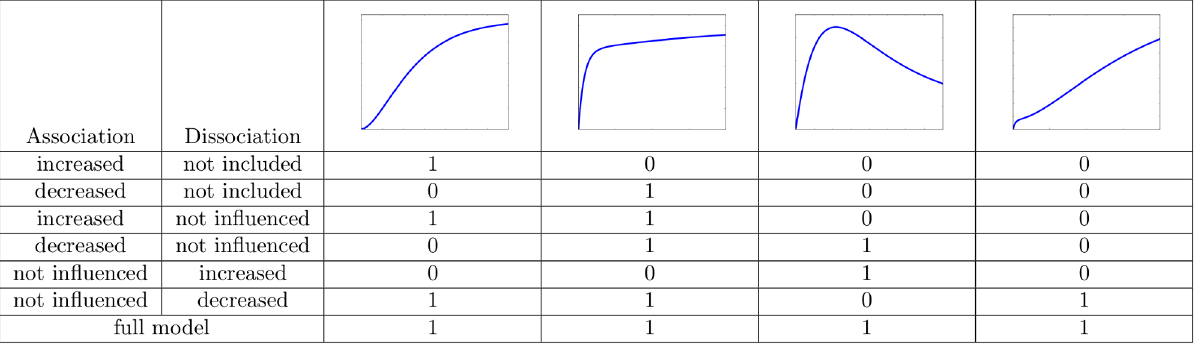
Figure S1 Model in which protein A decreases the ~ 0 . association rate of protein B : Special case k (cid:3) SA z B ~ k (cid:3) ~ 0 : 3 (solid curves), k (cid:3) ~ k (cid:3) ~ 1 : 2 k (cid:3) S z A SB z A S z A SB z A ~ 0 : 5 and k (cid:3) ~ 0 . The recruitment (dashed curves), k (cid:3) S z B SA z B curve of B in the case with low A 0 (solid blue curve) has a higher maximum as the recruitment curve of B in the case with high A 0 (dashed green curve). This feature helps distinguishing the model ~ 0 ) from the model in which there is in which A blocks B ( k (cid:3) SA z B no influence on B . For further explanation see section B1.2 in the paper. (EPS)